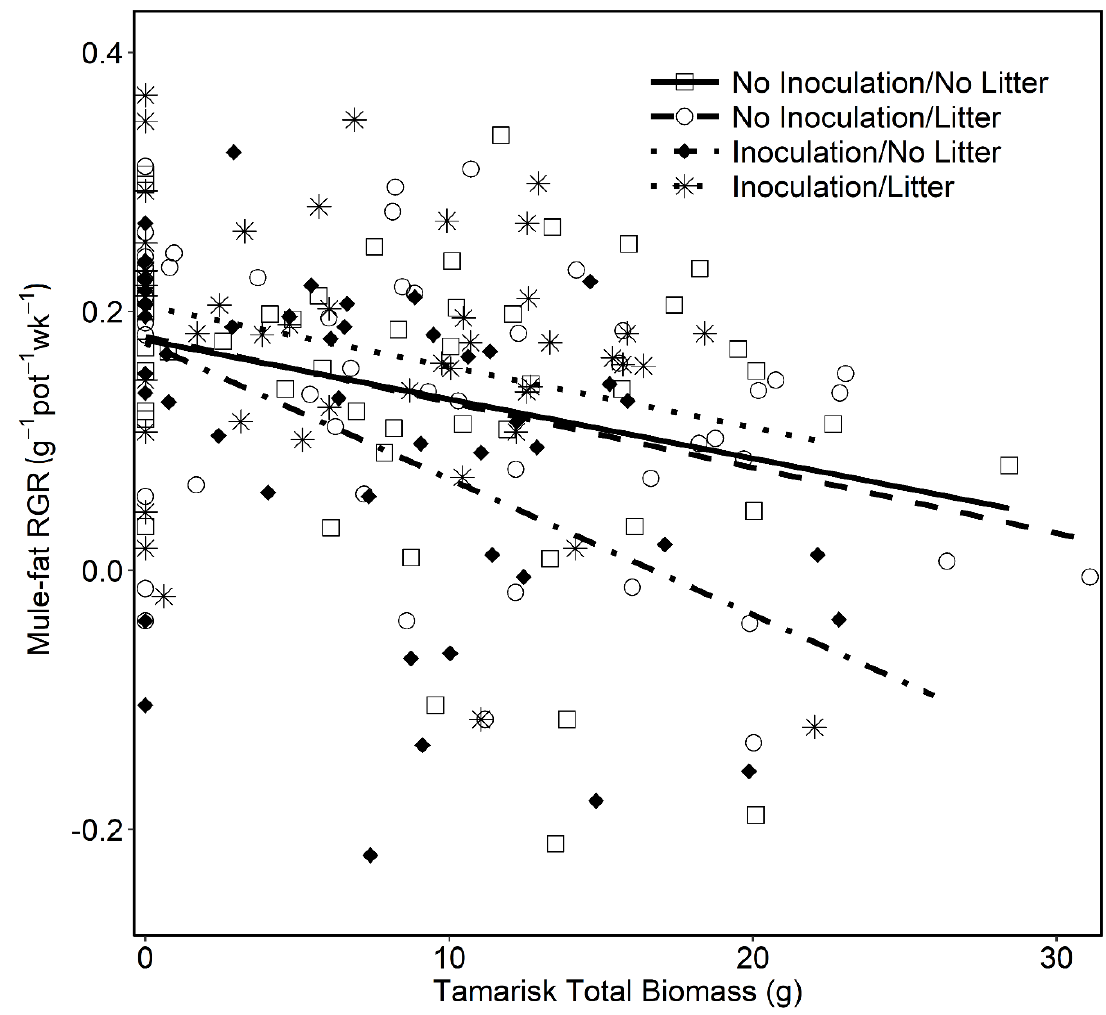
Figure 2. Mule-fat ( Baccharis salicifolia ) relative growth rate response to tamarisk ( Tamarix chinensis ) biomass in competition experiments, with and without a mycorrhizal inoculant and tamarisk litter. Regression lines are based on the calculated mule-fat relative growth rate and final measured tamarisk biomass.